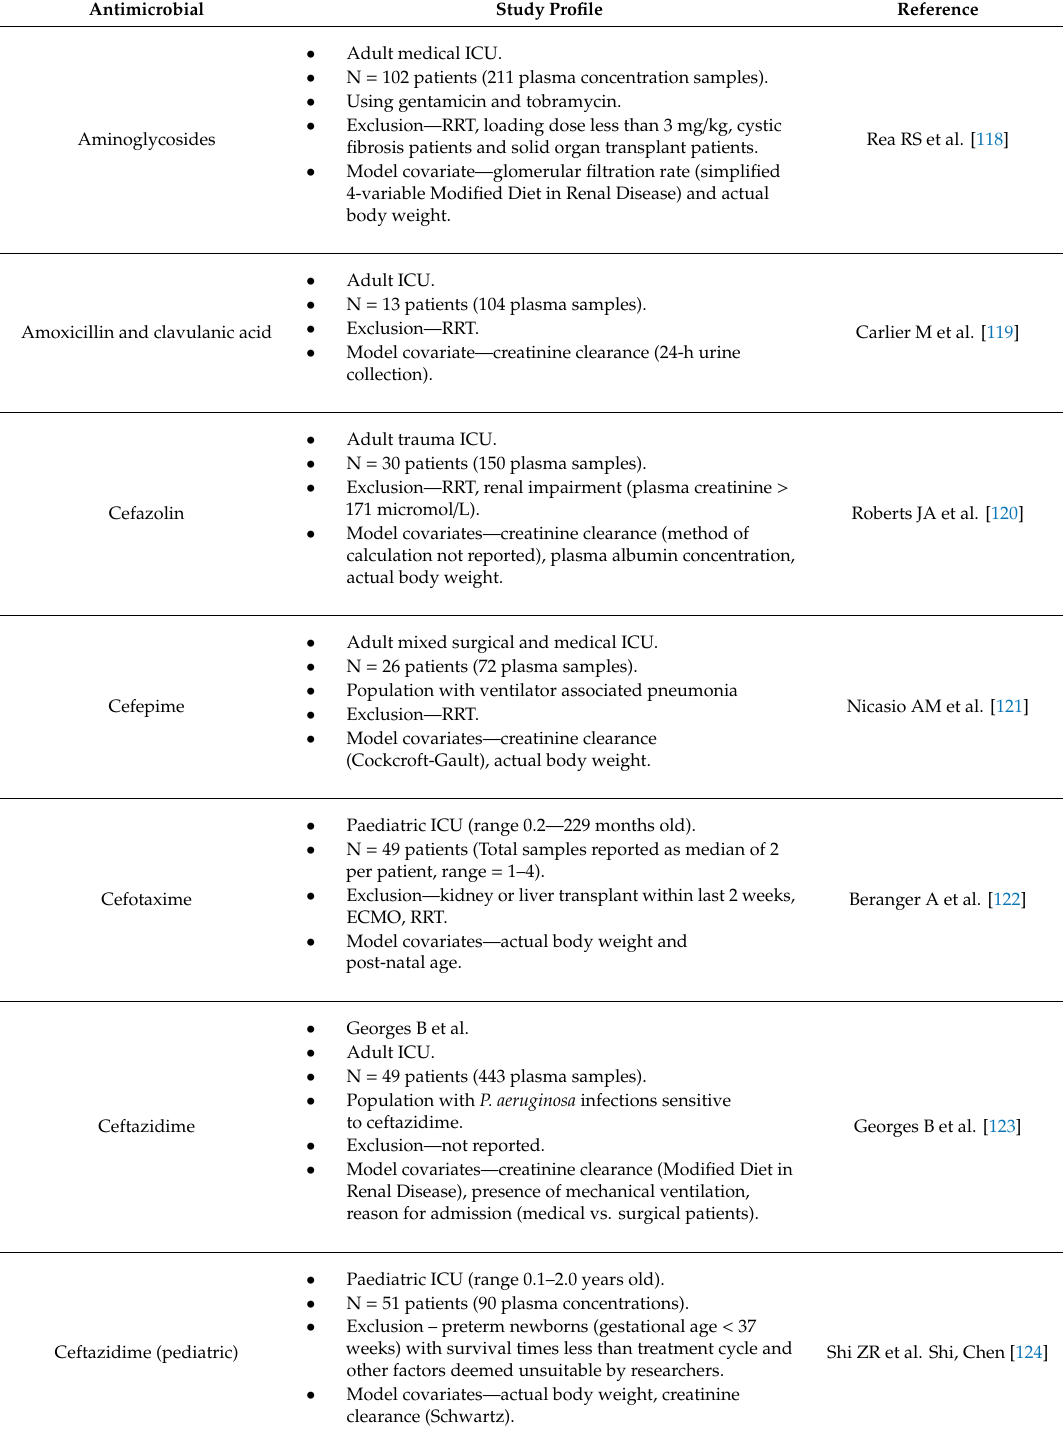
Table A1. Antimicrobial population PK models developed from critical care patient